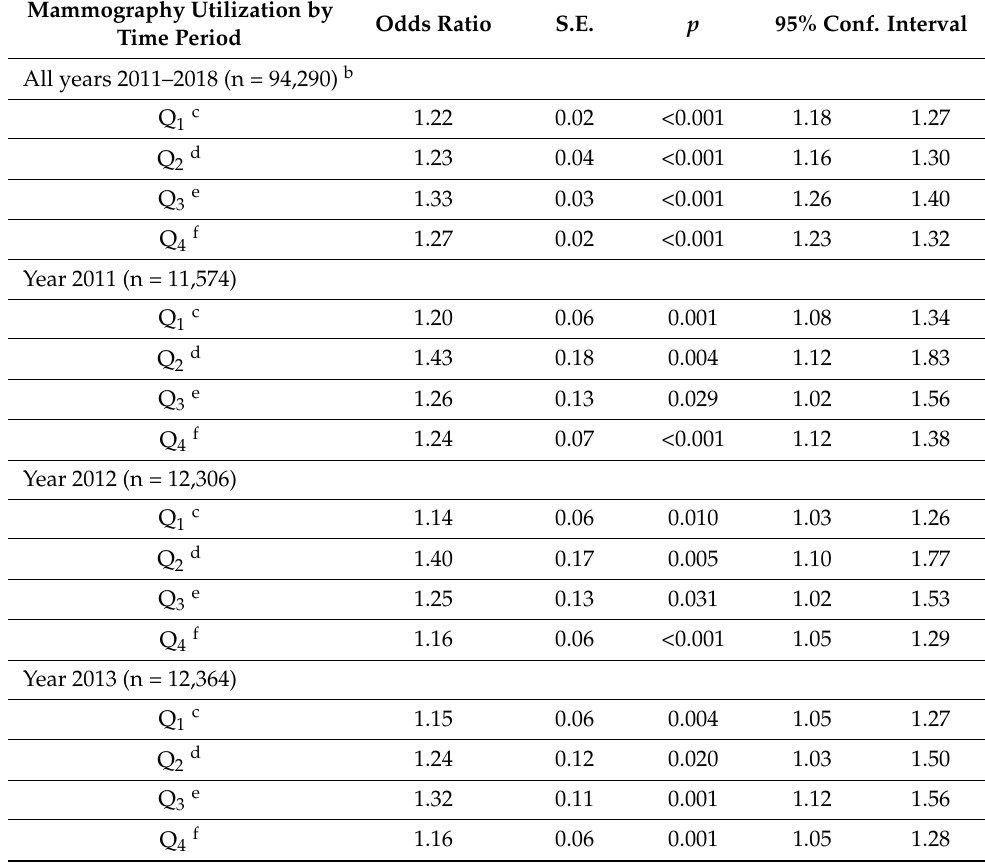
Table 2. Odds ratio and 95% CI based on multiple logistic regression, 2011–2018. Adjusted model 1 a . Mammography Utilization by Odds Ratio S.E. p 95% Conf. Interval Time Period All years 2011–2018 (n = 94,290) b Q 1